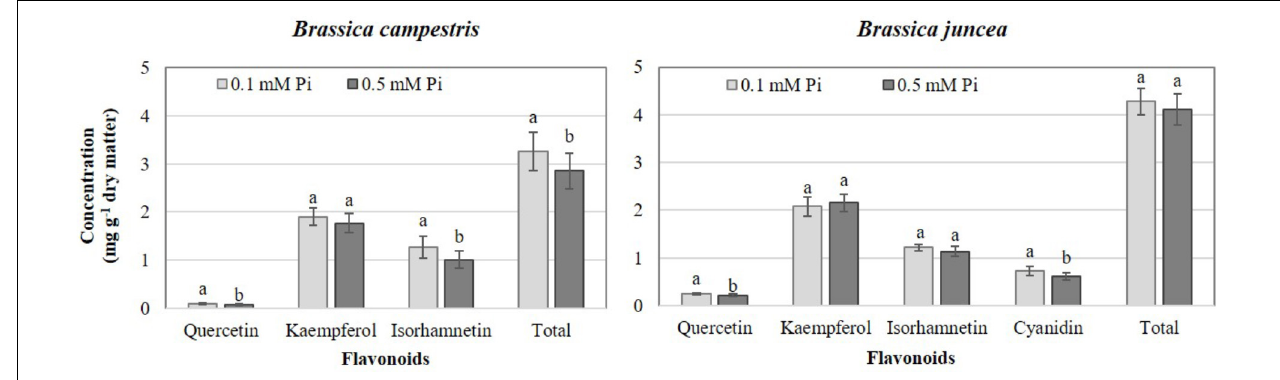
FIGURE 3 | Effects of phosphate (Pi) on flavonoid concentration in two Brassica species. Means ± SD with different letters in each subfigure and different letters indicate significant differences at P ≤ 0.05 (Tukey’s test).